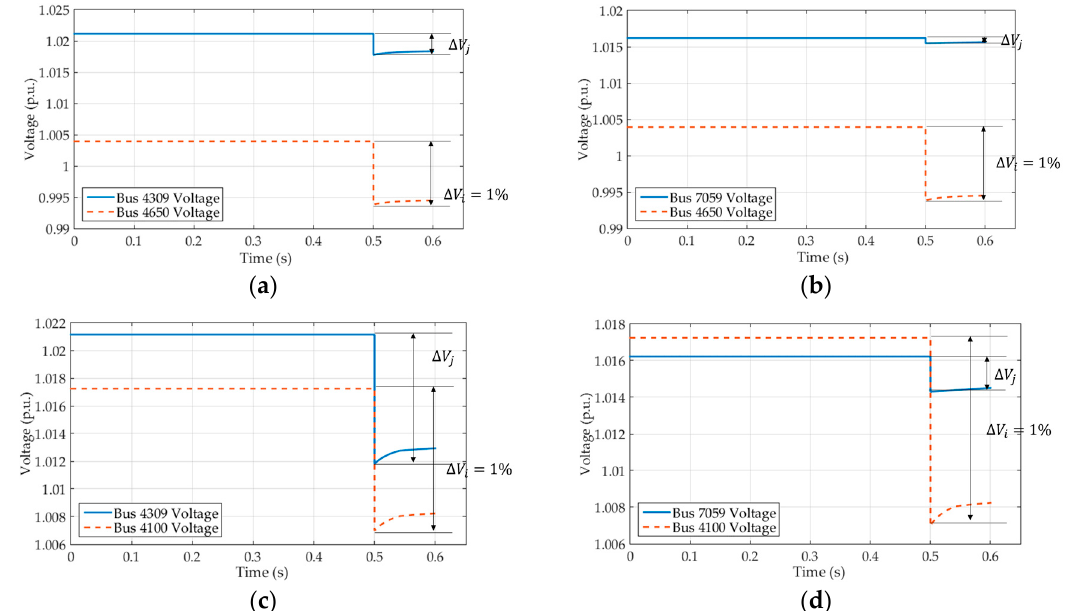
Figure 10. Korean power-system case 2 MIIF simulation result by dynamic method: ( a ) MIIF1 simulation result; ( b ) MIIF2 simulation result; ( c ) MIIF3 simulation result; and ( d ) MIIF4 simulation result.